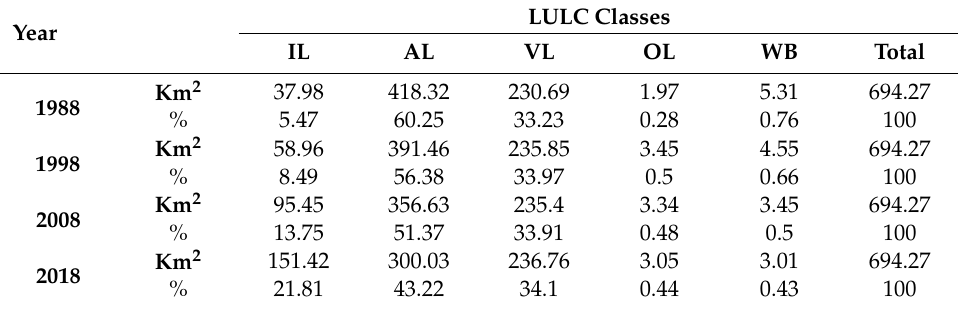
Table A2. The summary Land Use / Land Cover statistics of Kathmandu at 10-years interval from 1988 to 2018.